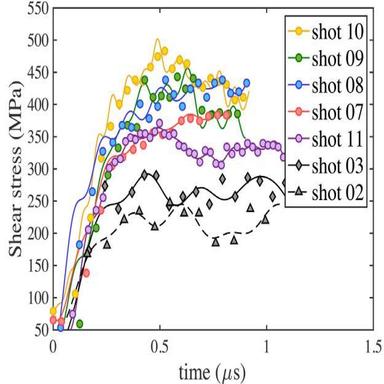
Shear stress history summary for all PSPI shots. All curves are shifted relative to the starting time of the second stress rise. Note that while the TDI (and thus the shear stress history) was available for shot 02 and shot 03, the corresponding NDI signals were not obtained.